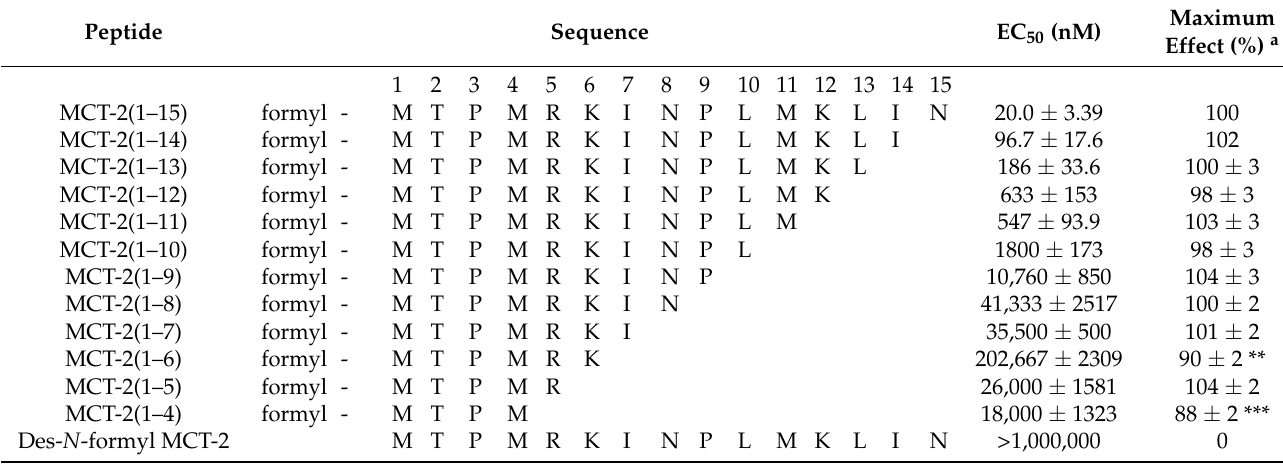
a The ability of each peptide to cause β -hexosaminidase release is expressed as a percentage of enzyme secretion promoted by 10 µ M MCT-2(1–15). Data are expressed as the mean ± SE of four to six independent experiments. ** p < 0.01; *** p < 0.001, values significantly different from